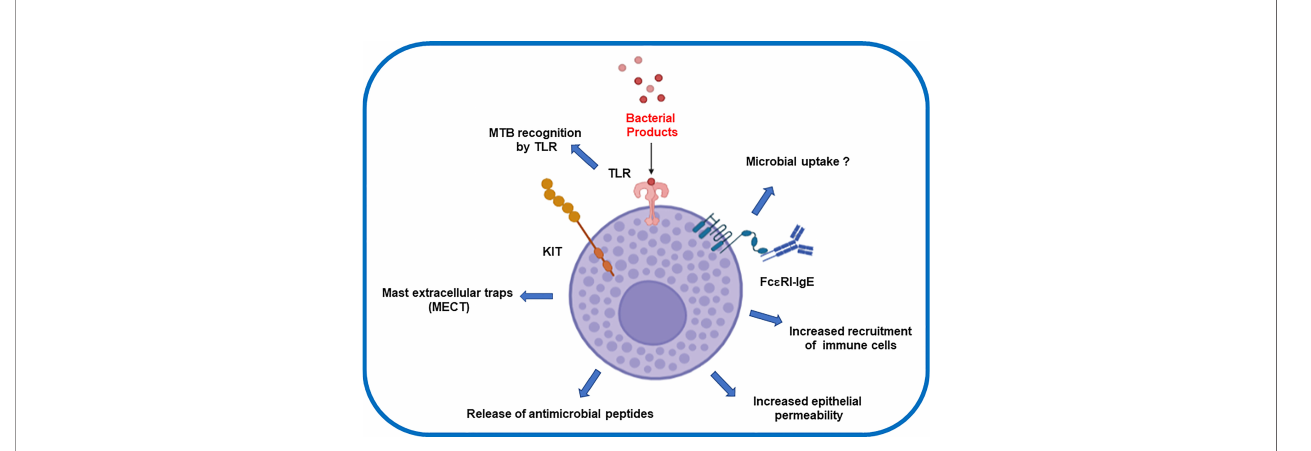
FIGURE 1 | Effector in fl ammatory response after mast cells interaction with Mycobacterium